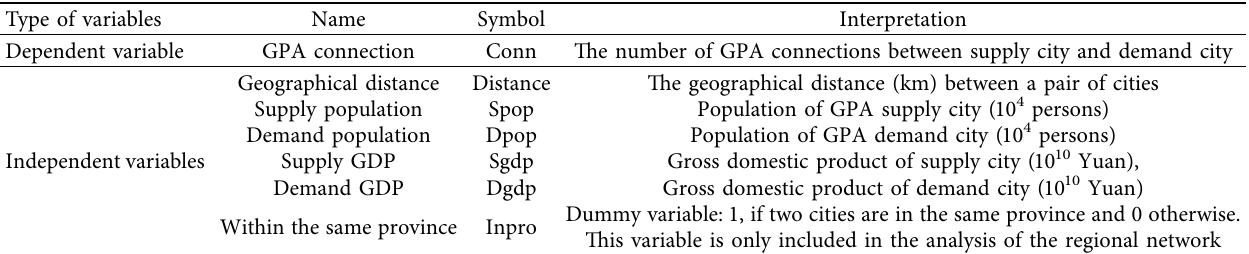
Table 4: Variables examined in the regression analysis.